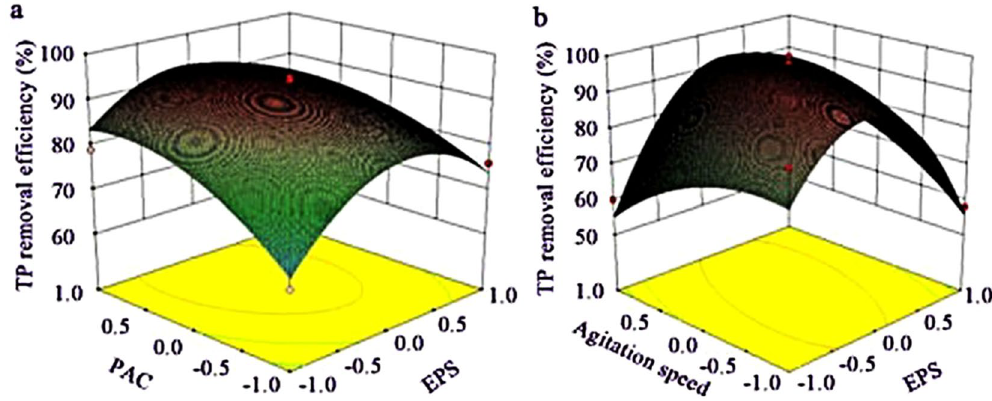
Figure 6. Surface graphs of turbidity removal efficiency showing the effect of variables: ( a ) PAC -EPS; ( b ) EPS- agitation